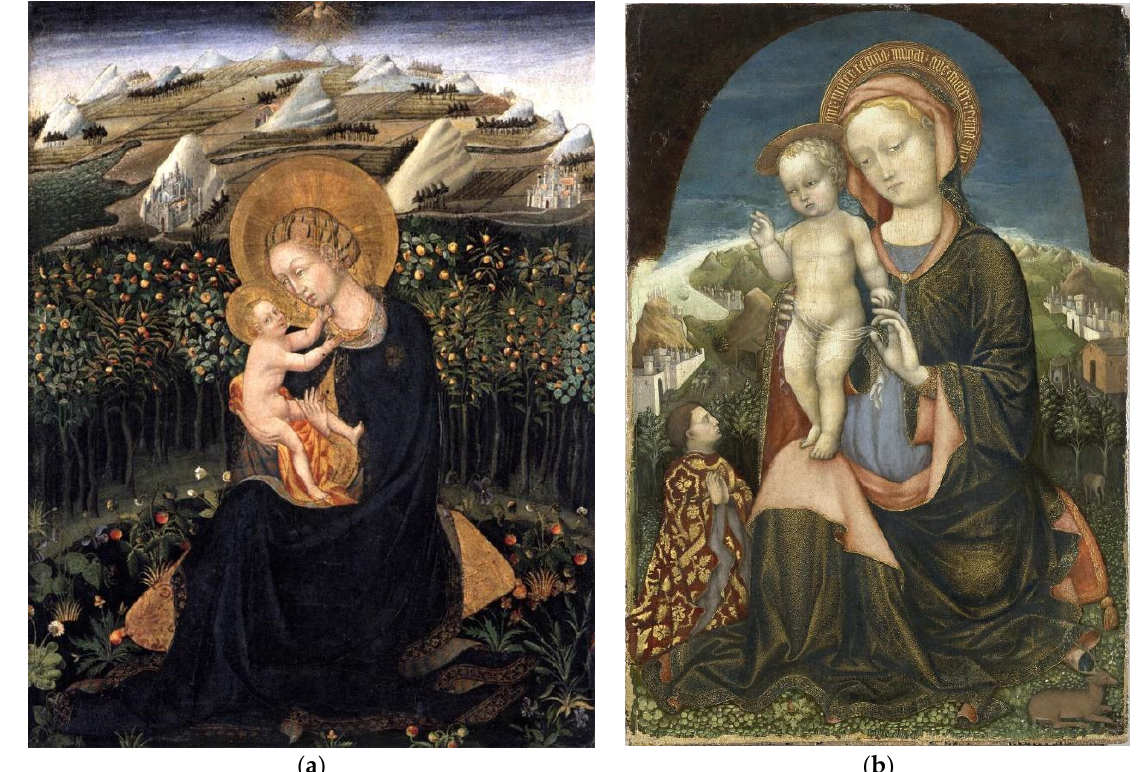
Figure 9. ( a ) Madonna of Humility , Giovanni di Paolo, c. 1442, Boston, Museum of Fine Arts, 30.772; ( b ) La Vierge d’Humilité adorée par un prince de la maison d’Este , attrib. Jacopo di Niccolo Bellini, second quarter of the 15th century, Paris, Musée du Louvre, RF 41.